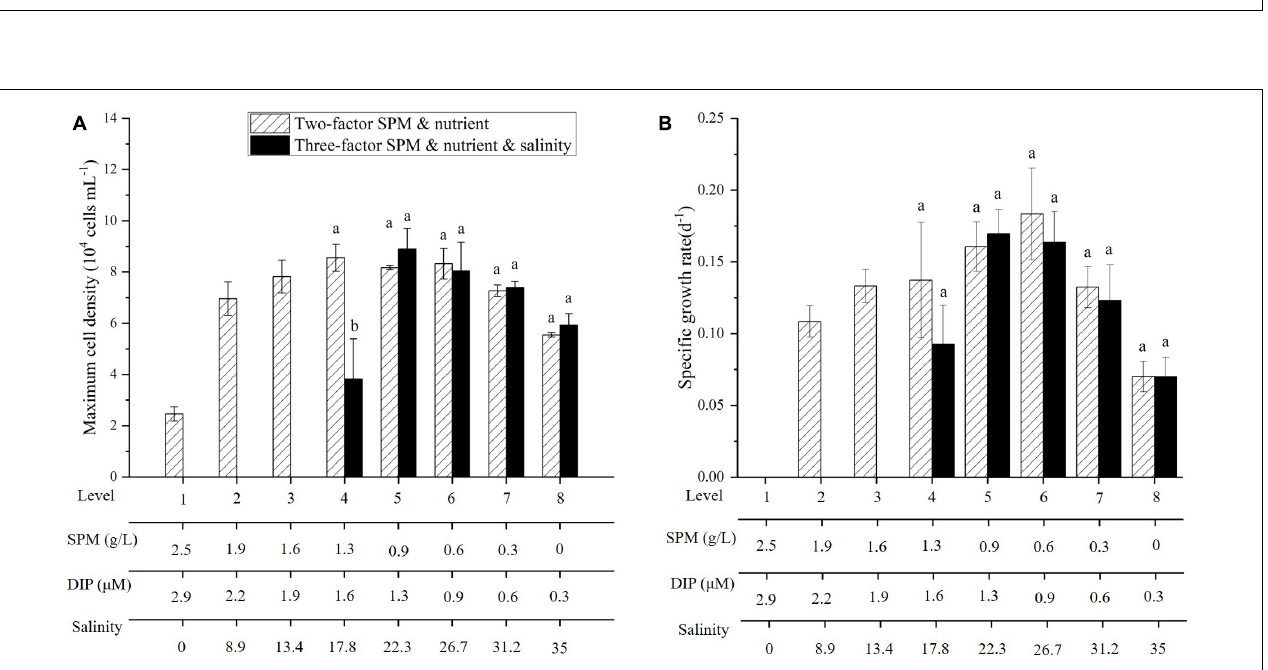
FIGURE 9 | Comparison of maximum cell density (A) and specific growth rate (B) of A. carterae in the two-factor and three-factor experiments. Different letters (a, b) indicate significant differences among treatments when compared to the two-factor experiment.